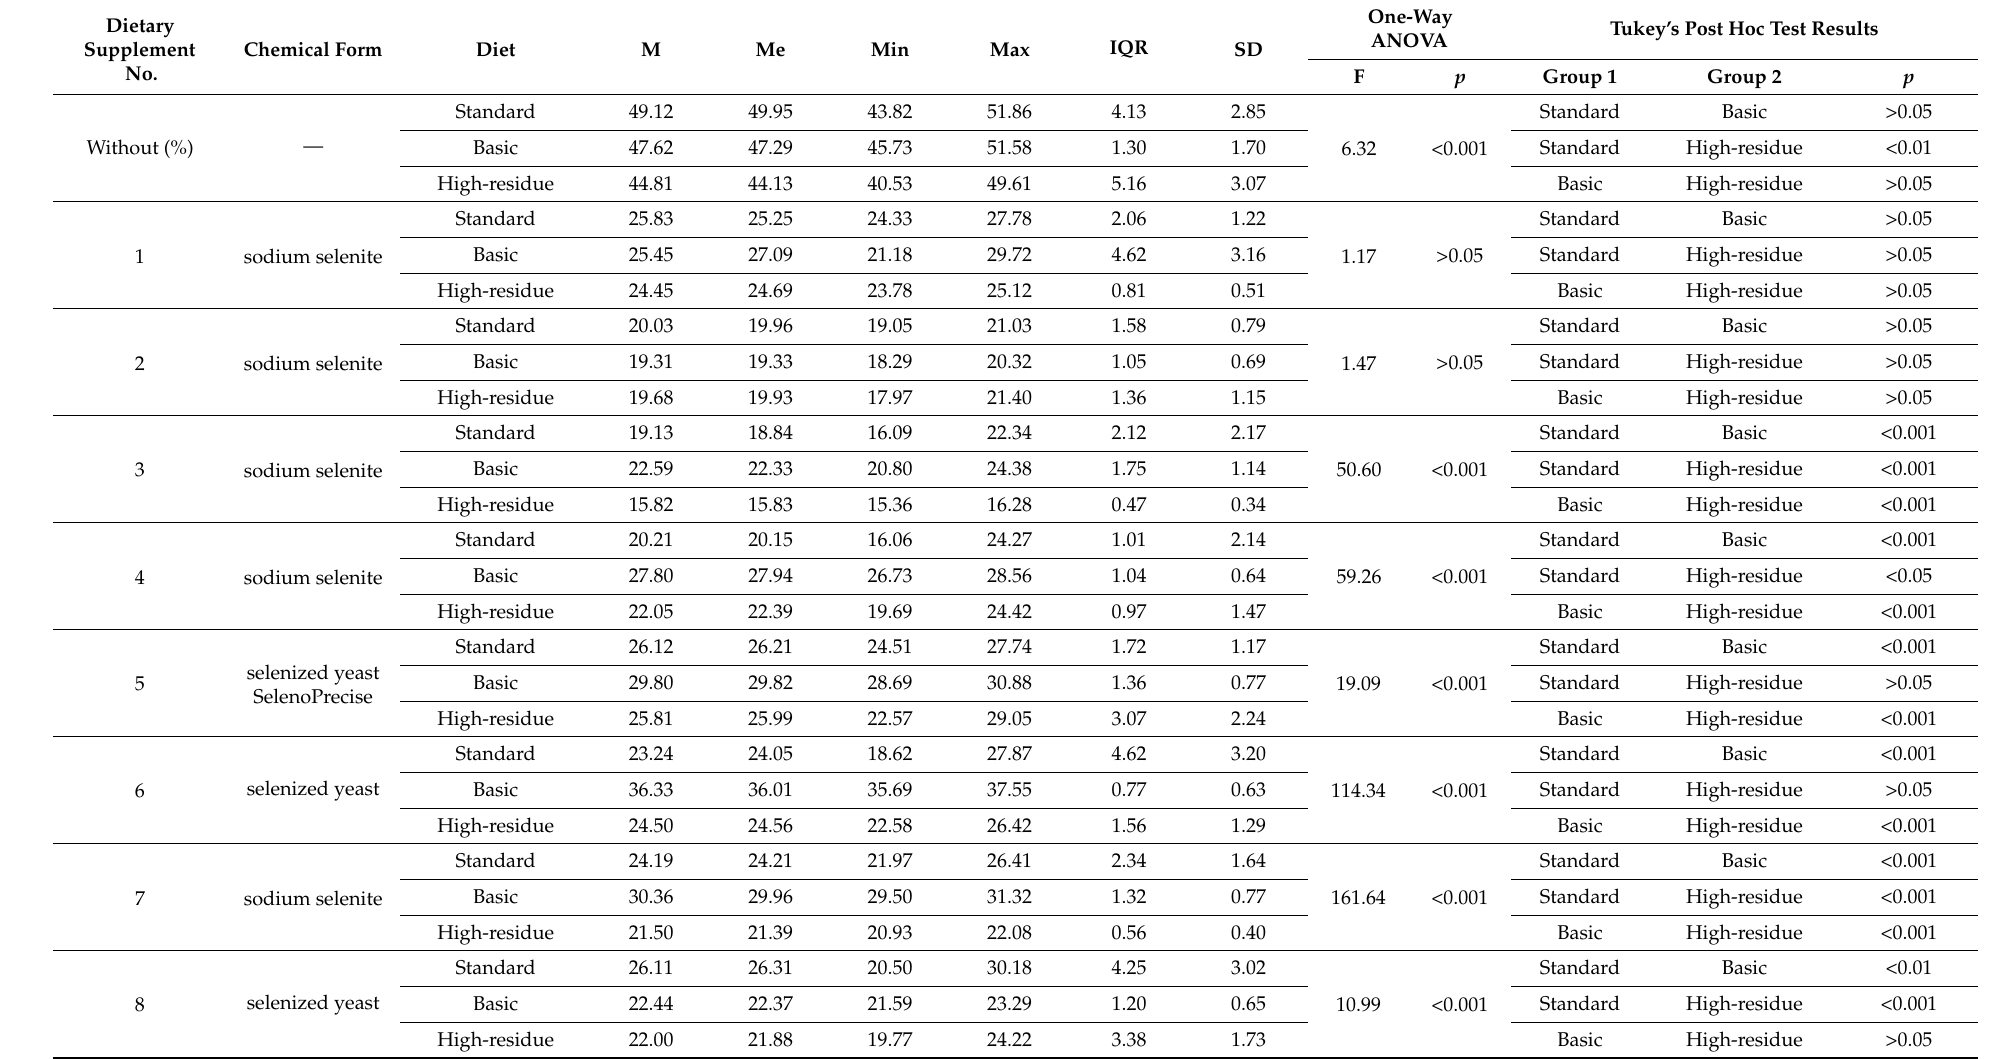
Table 3. Bioavailability of Se from dietary supplements under the influence of various types of